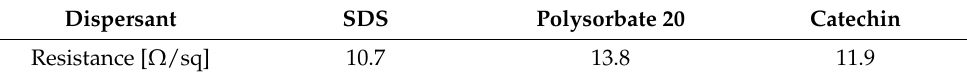
Figure 7. Variation over time of pressure generated with various dispersants. Table 1. Resistance value of CNT-composite paper when each dispersant is used.